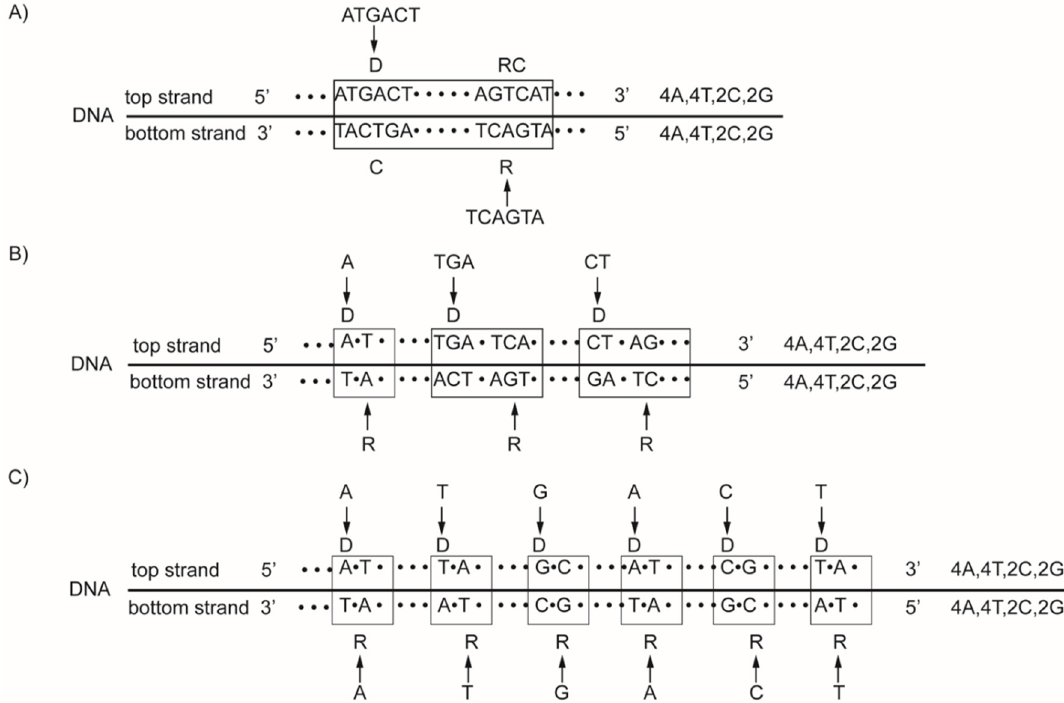
Figure 1. Examples for the natural symmetry law of DNA creation and conservation. According to this law, all mono/oligonucleotides which enter one strand of DNA must enter the second strand regardless of their localization. ( A ) Example with the entrance of a 6 nt oligonucleotide, ATGACT, into the top strand, reading its reverse oligonucleotide TCAGTA unidirectionally or reading the direct form of ATGACT bidirectionally (5 ′ 3 ′ ↔ 3 ′ 5 ′ ), entering the bottom strand. Thus, mirror symmetry between both strands is created. Due to Watson–Crick pairing and mirror symmetry, the quadruplet structures are formed, automatically fulfilling CSPR: f D = f RC. ( B ) The same nucleotides may also enter as mononucleotide (A), trinucleotide (TGA) and dinucleotide (CT). The farther process and result are identical, as in A. ( C ) The same 6 nucleotides can enter the top strand and the bottom strand individually as mononucleotides. Binding with a complementary pair, the quadruplet structures are created, and the final CSPR result is identical, as in cases A and B. It can be seen how the bidirectional DNA structure is formed: AT(D) in the top strand and TA(R) in the bottom strand, or GC(D) in the top strand and CG(R) in the bottom strand.